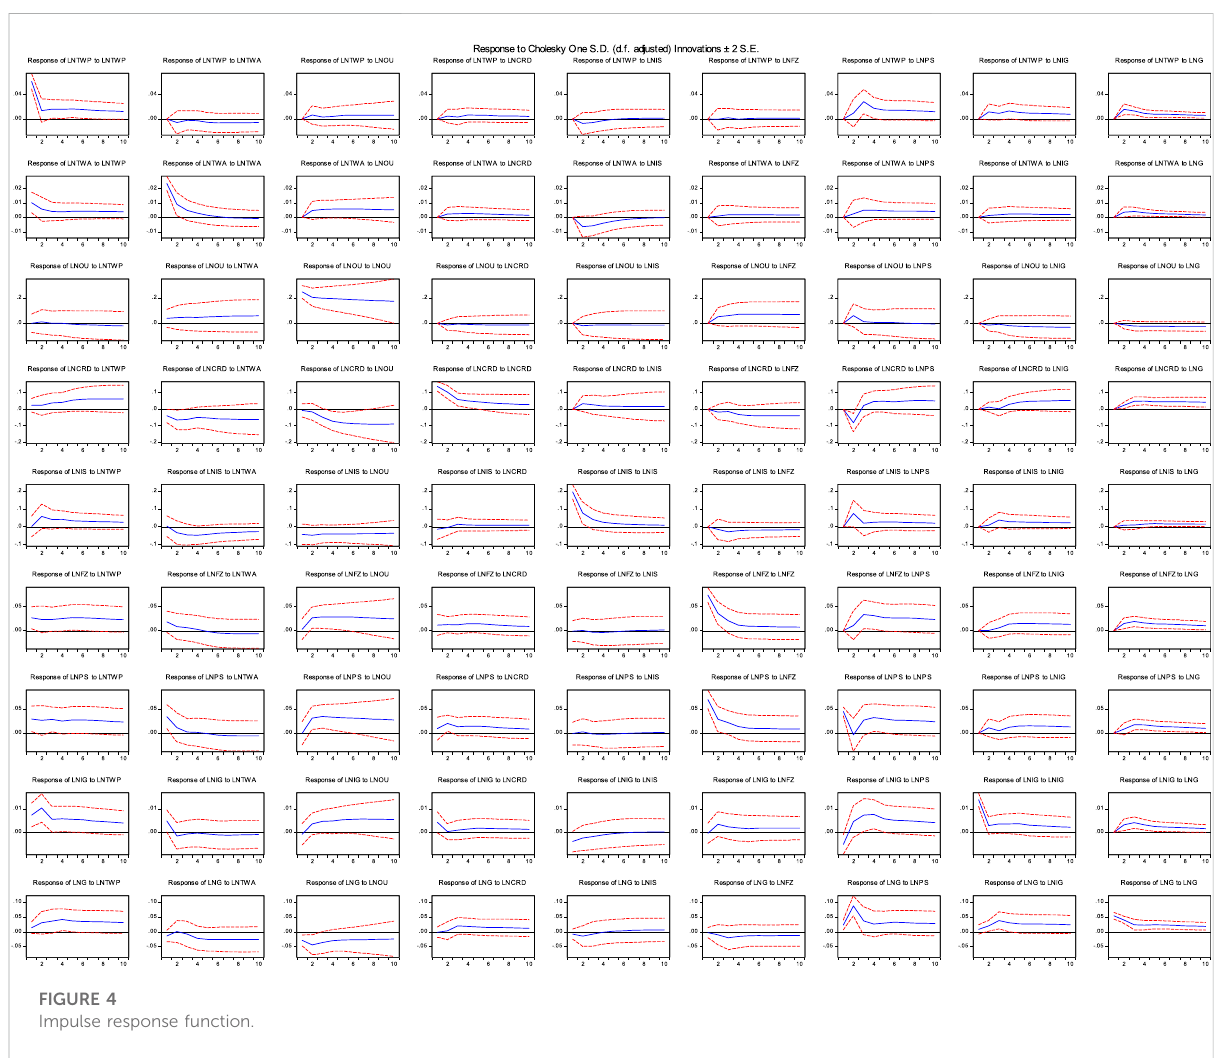
FIGURE 4 Impulse response